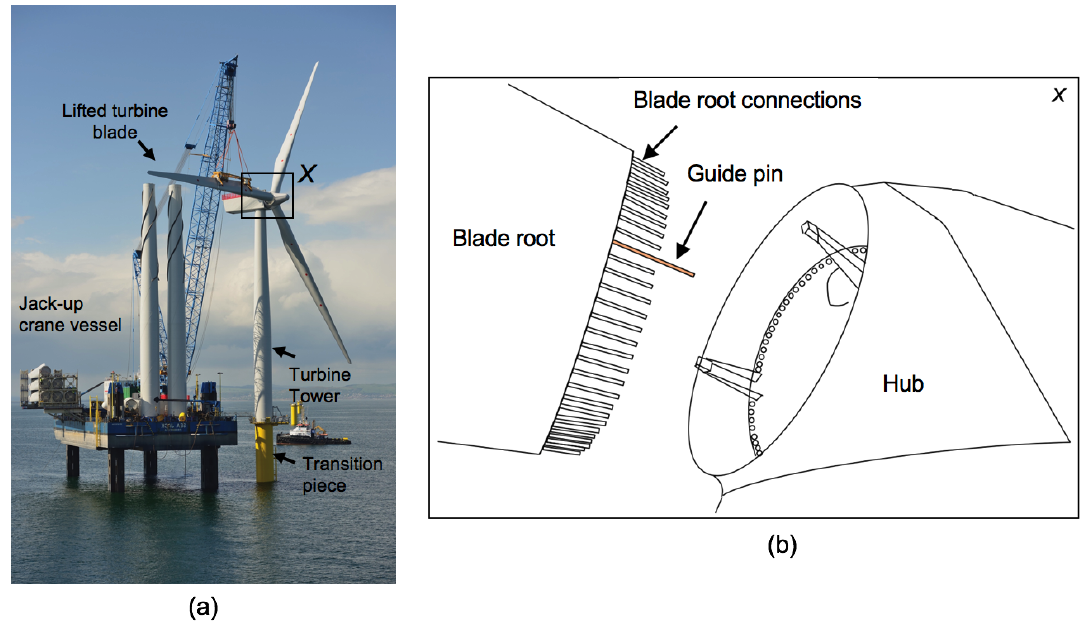
Figure 2. ( a ) Wind-turbine blade installation task using jack-up crane vessel [28]; ( b ) Magnified view of blade-root mating task